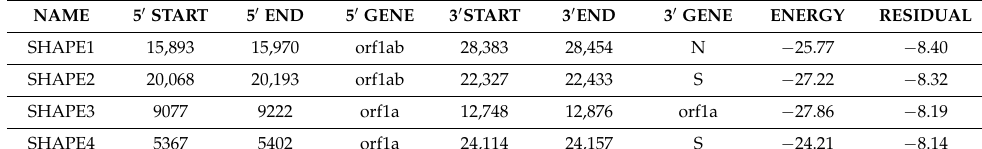
Table 6. List of computationally predicted RRIs with SHAPE data used in the analysis.